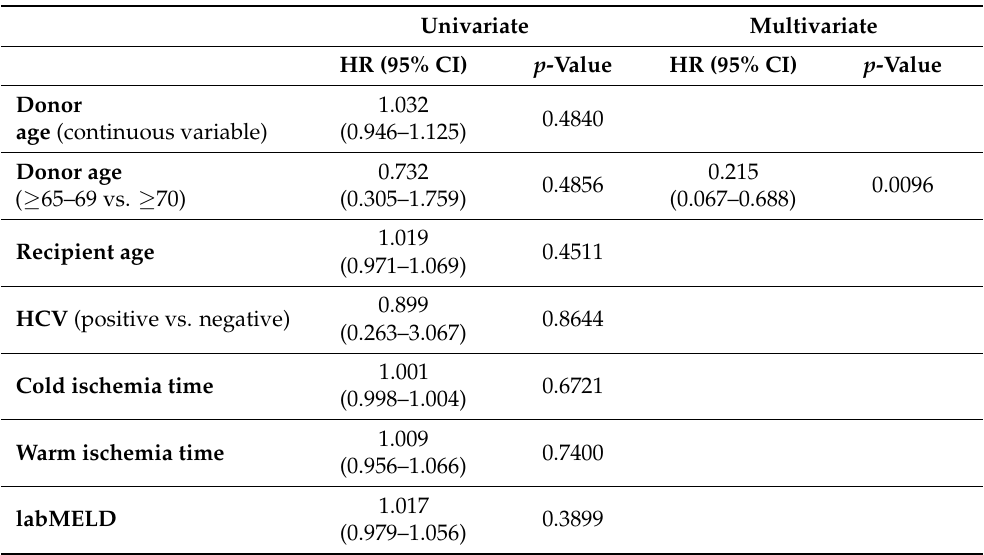
Table 6. Cox proportional hazards regression model with univariate and multivariable Cox regression analyses of one-year graft survival for recipients of grafts ≥ 65